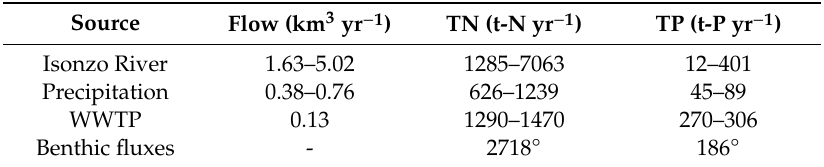
Table 1. Estimates of freshwater loads (km 3 yr − 1 ) and TN and TP inputs in the GoT (t yr − 1 ) due to Isonzo River (1998–2016), precipitation, sewage discharges (WWTP) and benthic fluxes of regenerated nitrogen and phosphorus from marine sediments to the water